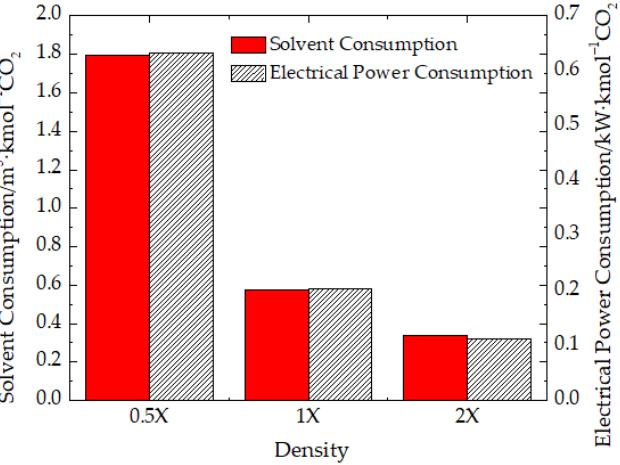
Figure 3. Effect of [emim][Tf 2 N] density on solvent circulation and energy consumption. The red represents the solvent consumption and the shaded part represents the electrical power consumption.